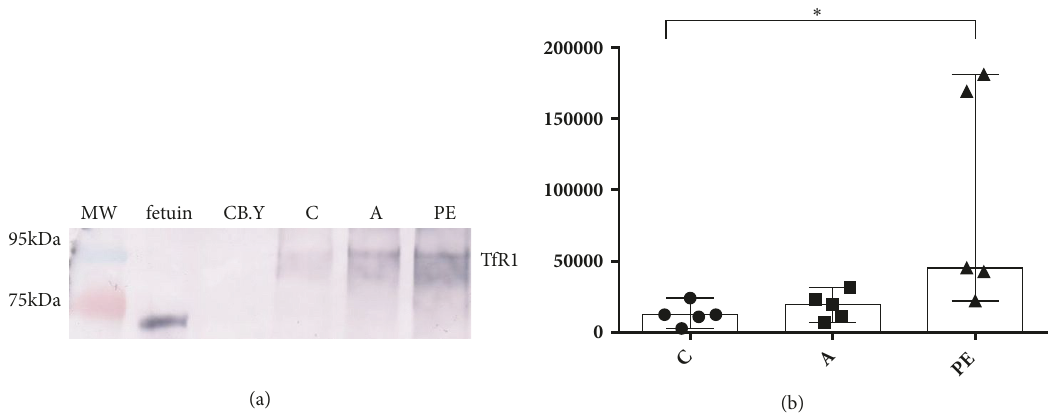
Figure 3: Expression pattern Gal-GlcNAc detected by the DSA lectin. (a) Representative image of a lectin blot; as positive control fetuin was used and as negative control carboxypeptidase Y (CB.Y). (b) Expression of the Gal-GlcNAc pattern of TfR1 in trophoblastic villi in the control group (C), the group with IDAP (A), and the group with early-onset severe preeclampsia (PE). The data are presented as median and range, Kruskal-Wallis statistical analysis, where p < 0.05 ∗ .